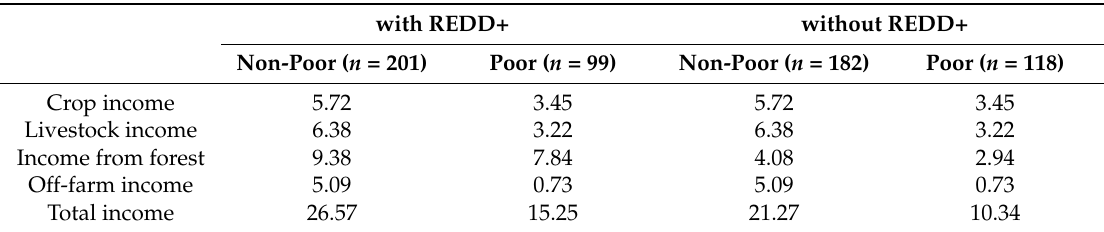
Table 10. Comparison of REDD+ program income by poor and non-poor households, Con Cuong District, Nghe An Province, 2016. with REDD+